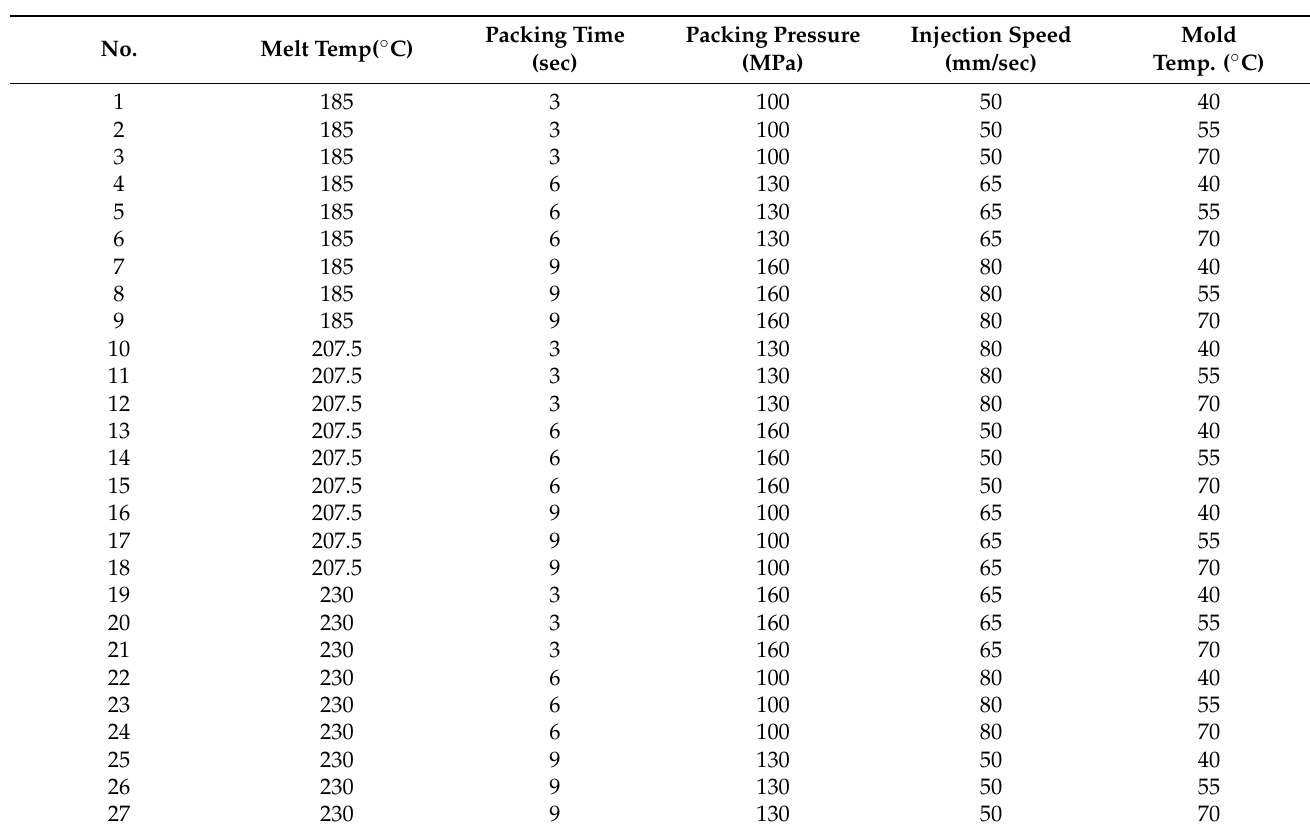
Table 4. Square tablet training data (CAE-27).